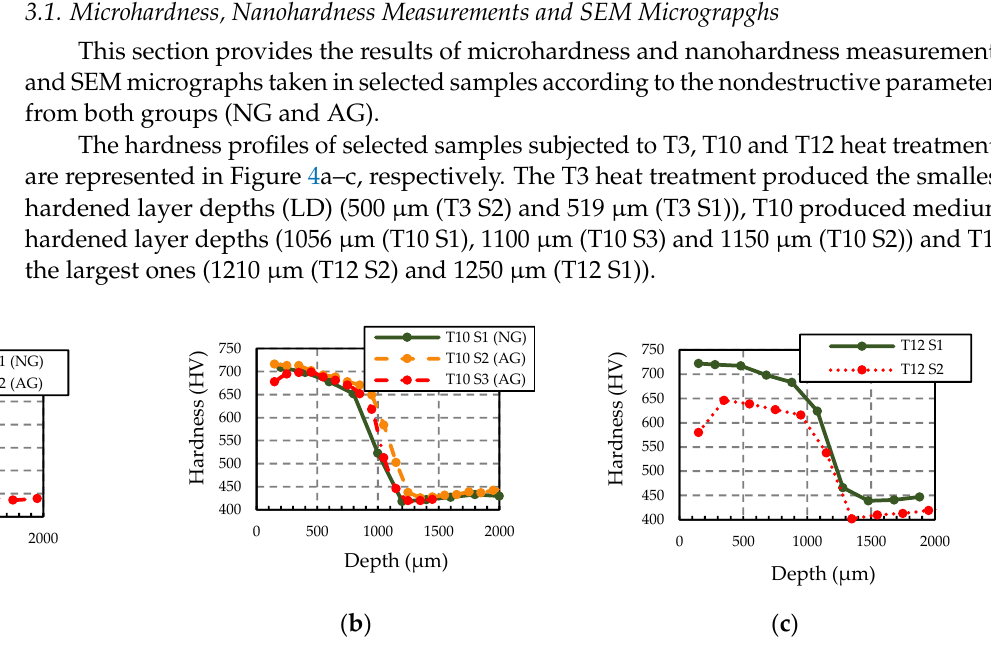
Figure 4. Microhardness measurements in normally and abnormally ground samples subjected to different heat treatments with varying hardened layer depth (LD): ( a ) T3 (LD ≈ 500 μm) , ( b ) T10 (LD ≈ 1100 μm) and ( c ) T12 (LD ≈ 1250 μm). The standard deviation of Vickers measurement at the surface area is 0.5 HV and in the transition area of 1.1 HV.